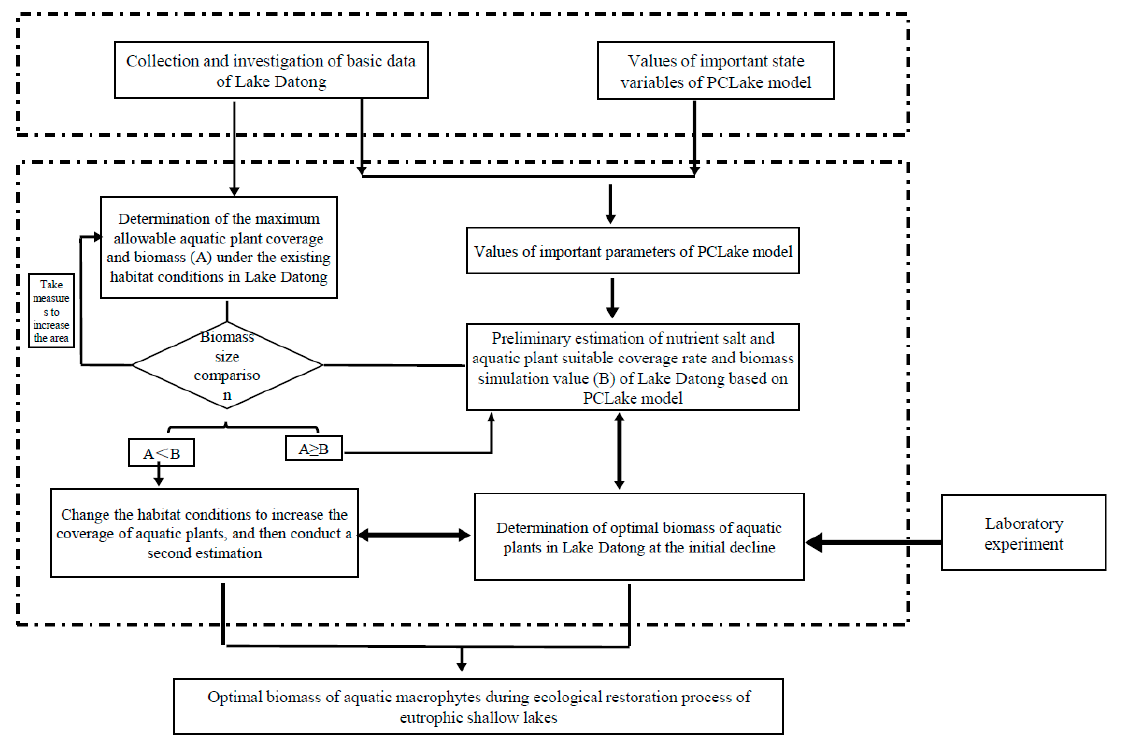
Figure 2. Roadmap of research.